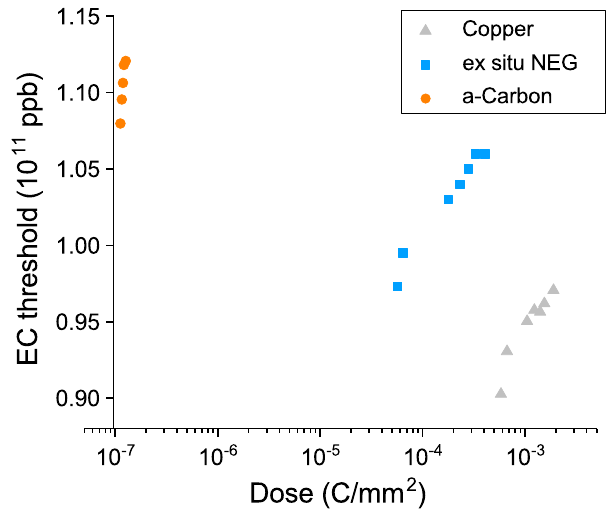
FIG. 8. Pressure trends as a function of the number of protons per bunch after the injection phase of a 25 ns standard LHC beam in linear at 450 GeV.